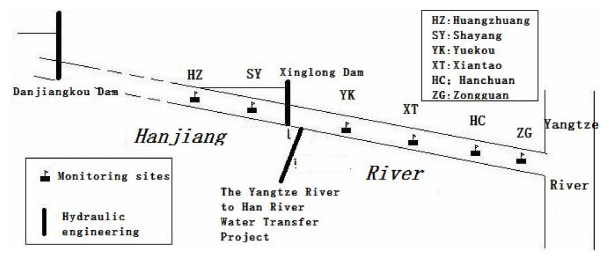
Figure 1. Layout of Emergency Monitoring Cross